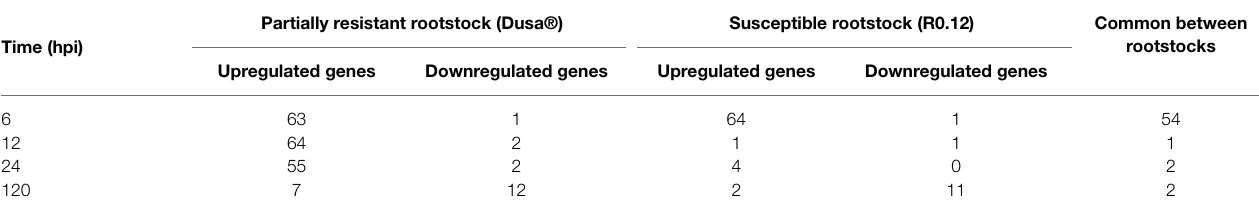
TABLE 2 | Number of PaNLR genes expressed in two avocado rootstocks in response to Phytophthora cinnamomi inoculation at different timepoints post-inoculation, when compared to mock-inoculated rootstocks (hpi, hours post-inoculation). Partially resistant rootstock (Dusa®) Susceptible rootstock Time (hpi)